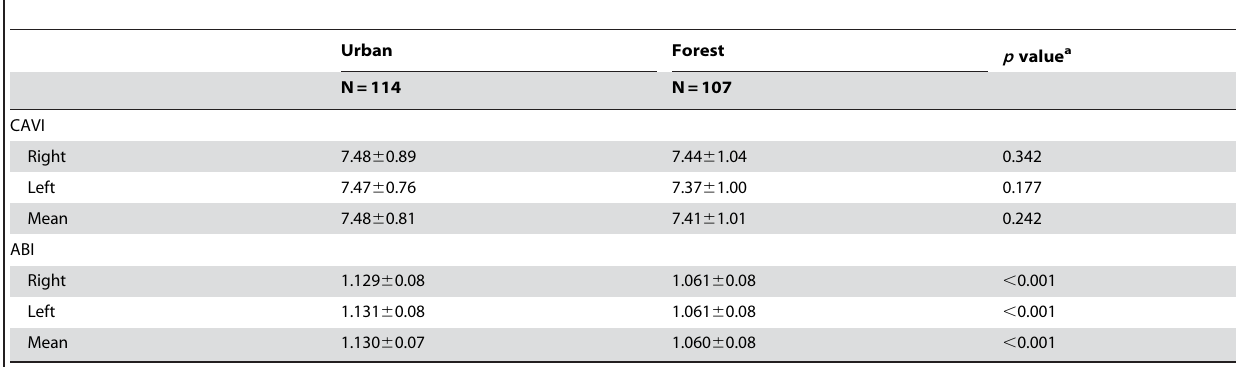
Table 5. Cardio-ankle vascular index (CAVI) and ankle brachia index (ABI) of urban and forest staff member groups.